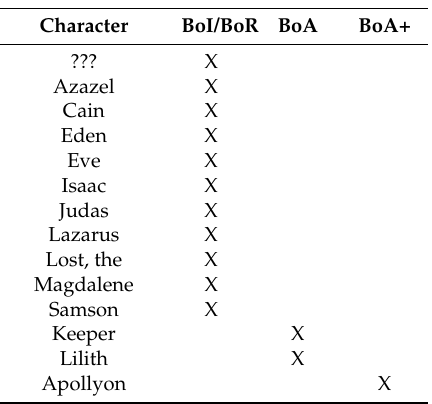
Table 2. Unlockable characters in The Binding of Isaac